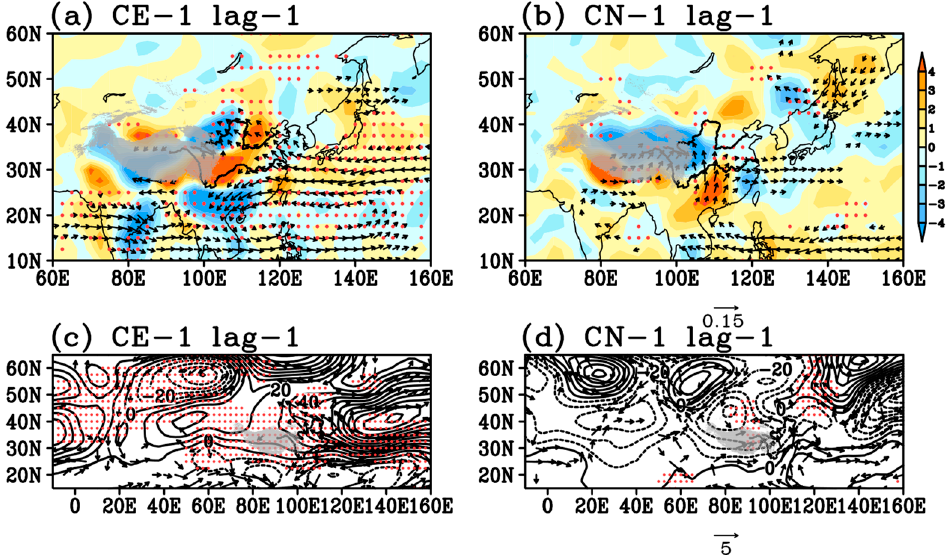
Figure 10. The difference (extreme minus normal) of the composited water vapor transport (vectors, m·kg·s − 1 ·kg − 1 ) and its divergence (color shadings) ( a , b ) and of the composited 500 hPa geopotential height (contours) and 850 hPa wind vector (vectors, m·s − 1 ) ( c , d ) between the composites based on the Lag − 1 days of the events in CE-1 and CN-1 ( a , c ) and in CE-2 and CN-2. The red dots denote the 95% confidence level.